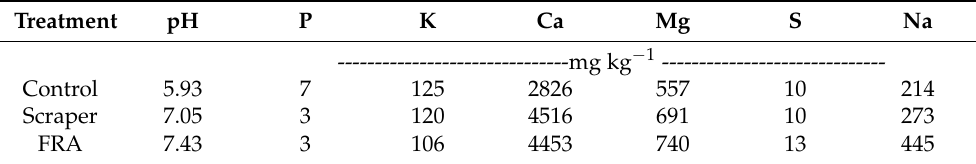
Table 3. Mean soil pH, phosphorus (P), potassium (K), calcium (Ca), magnesium (Mg), sulfur (S) and sodium (Na) by treatment measured at a depth of 15 cm.